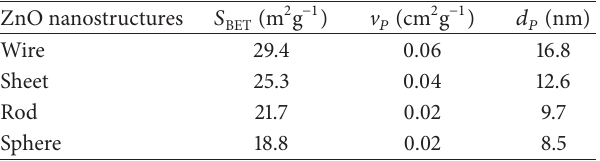
Table 1: BET surface area and pore structure parameters of the